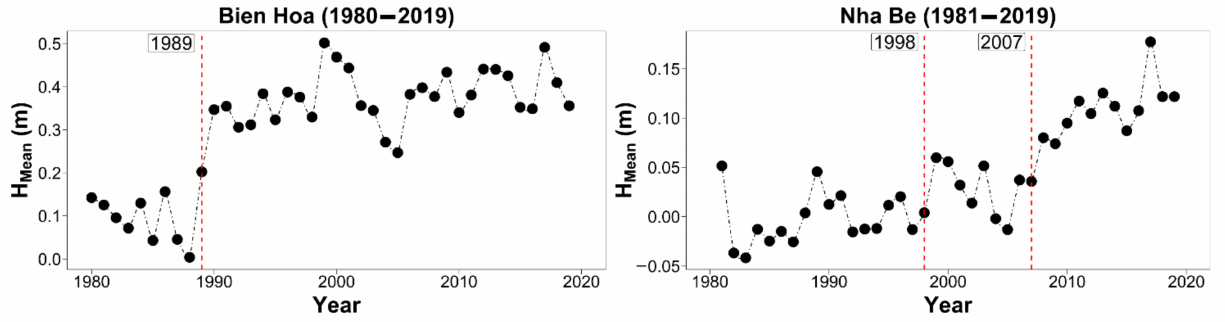
Figure A3. Changepoint years showing the possible shifts in H p99% .